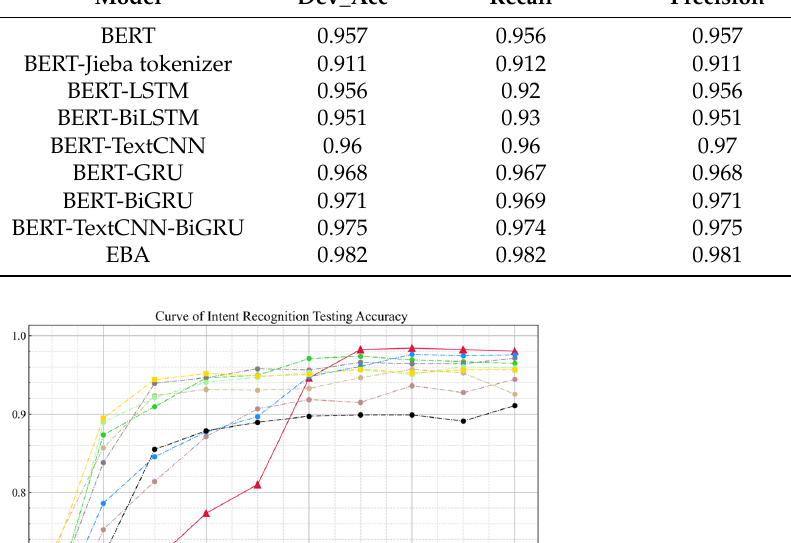
Table 6. Comparison of the effect of different models on the ATC instruction intention recognition dataset. Model